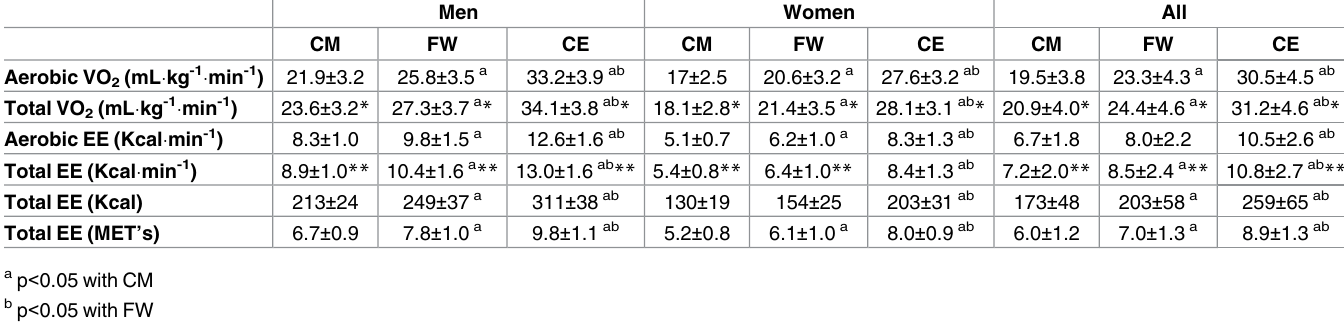
Table 3. Energy expenditure variables in each training protocol (mean ± SD) measuredduring Circuit Machine training protocol (CM), Free Weight training protocol (FW) and Combined Exercise training protocol (CE) in men (n = 15) and women (n =